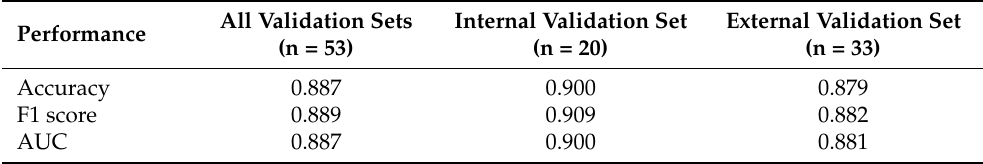
Table 3. Performance of our CNN model on validation sets.